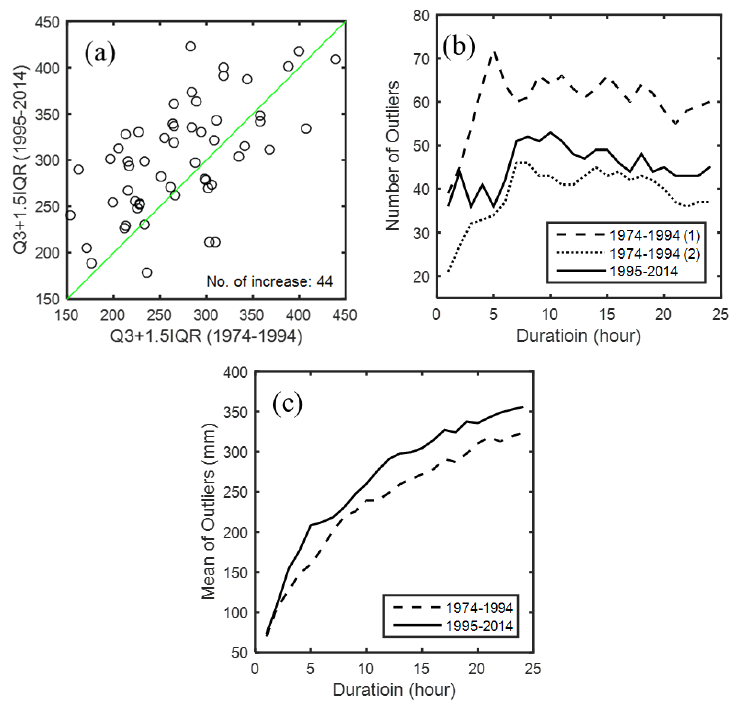
Figure 5. ( a ) Changes in the thresholds that determine the outliers for the annual maxima of 60 stations with a rainfall duration of 24 h; ( b ) number of outliers during 1974–1994 and 1995–2014; and ( c ) mean of the outliers for each period depending on the rainfall durations.